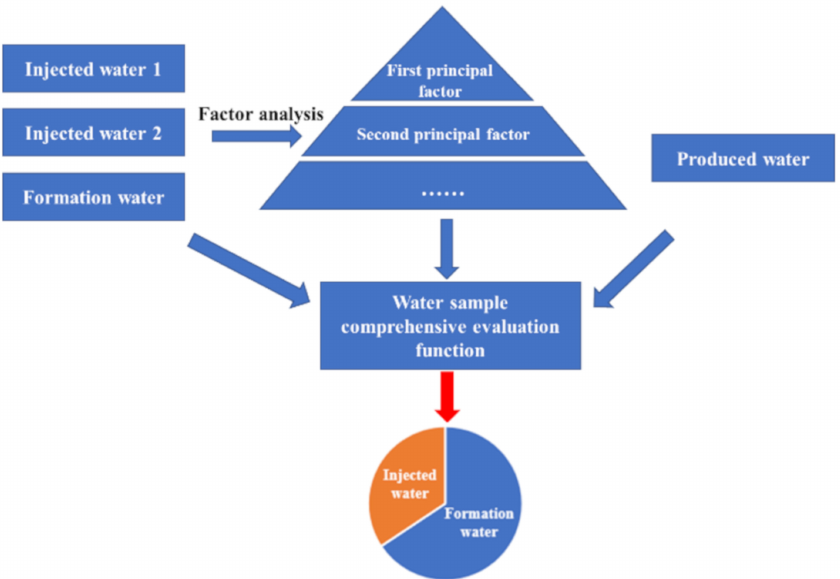
Figure 1. Flow chart of analysis method of produced